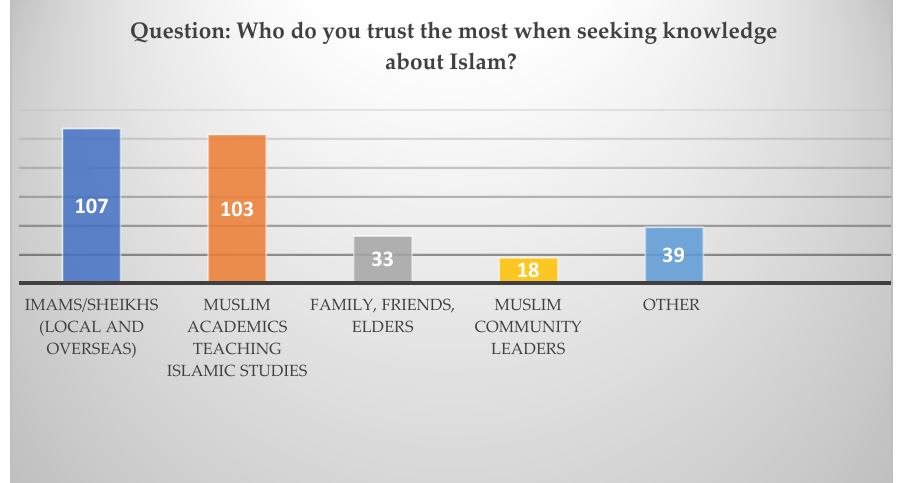
Figure 1. Muslim actors and Islamic knowledge.